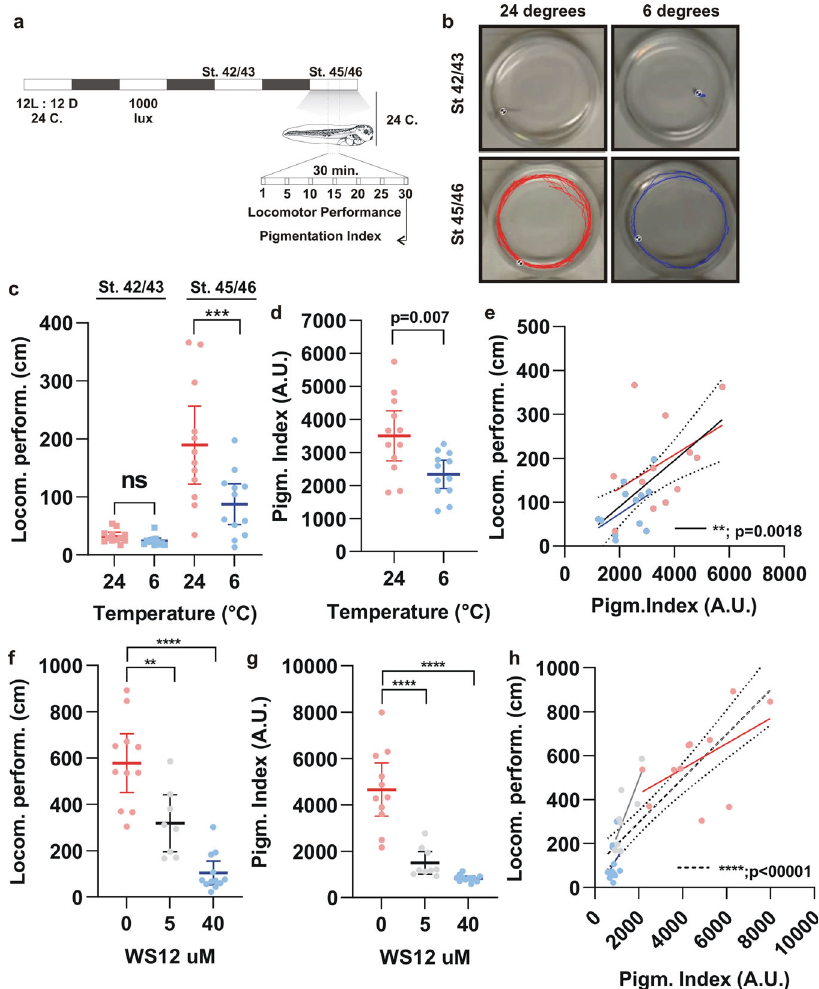
Fig. 5 Skin pigmentation and locomotor performance. a Schematic representation of the experimental approach. The locomotor performance was analyzed for stage 45/46 embryos by recording swim activity (1 min) every 5 min for 30 min. The pigmentation index of each tadpole was determined at the end of the study. b A representative analysis of the locomotor performance determined by tracking the distance swum at 24 °C (red) and 6 °C (blue). c , f Locomotor performance of embryos at 24 °C (red dots) or at 6 °C (blue dots) ( c ) or at 24 °C in the presence of WS12 (without WS12: red dots; 5 µ M: grey dots; 40 µ M: blue dots) ( f ). d , g Pigmentation index of stage 45/46 embryos at 24 °C or at 6 °C ( d ) or at 24 °C in the presence of WS12 ( g ). e , h Correlation between locomotor performance and the pigmentation index. The linear regression for each treatment is indicated with a red (24 °C) or blue (6 °C) solid line. Dotted lines represent the 95% con fi dence interval while the dashed line is the Pearson correlation coef fi cient (two-tail) from all data. ** p < 0.01, *** p < 0.001; **** p < 0.0001; ANOVA followed by Bonferroni ’ s test or Student ’ s t -test in d. Each dot represents the measurement for one tadpole, and the bar is the mean with 95% con fi dence interval; n = 8 embryos; N = 2 independent